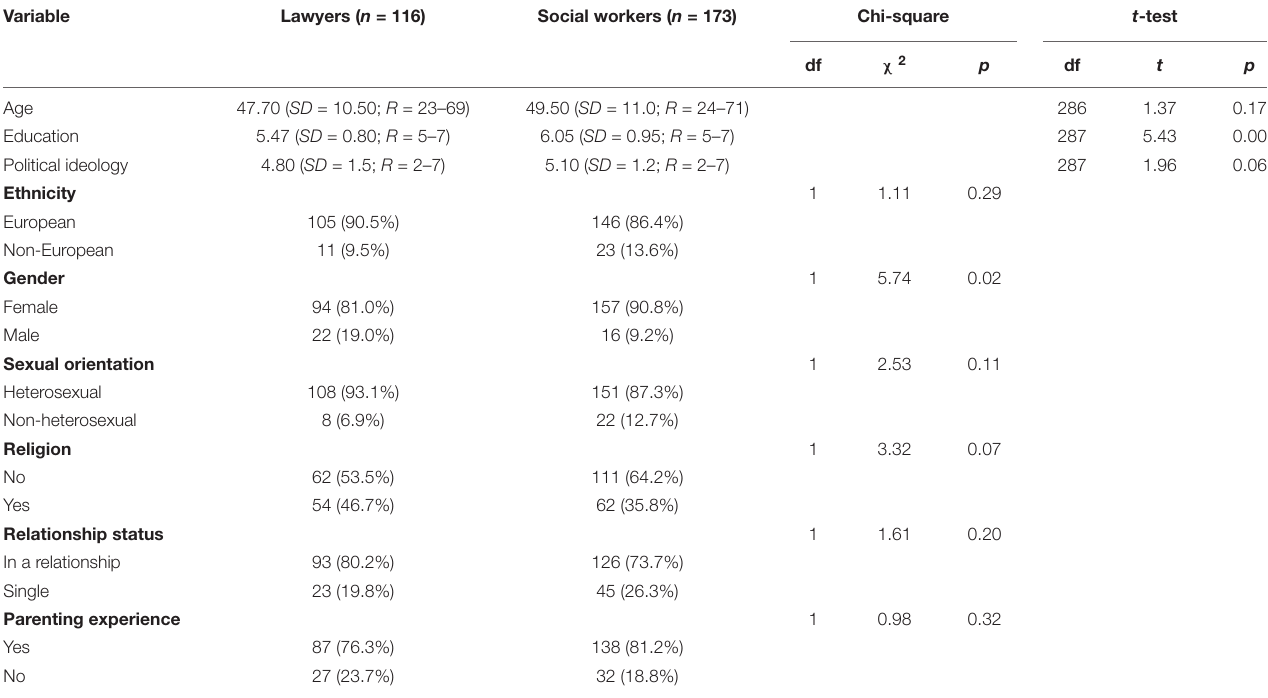
TABLE 1 | Summary of demographic backgrounds between lawyers and social workers ( N = 289).